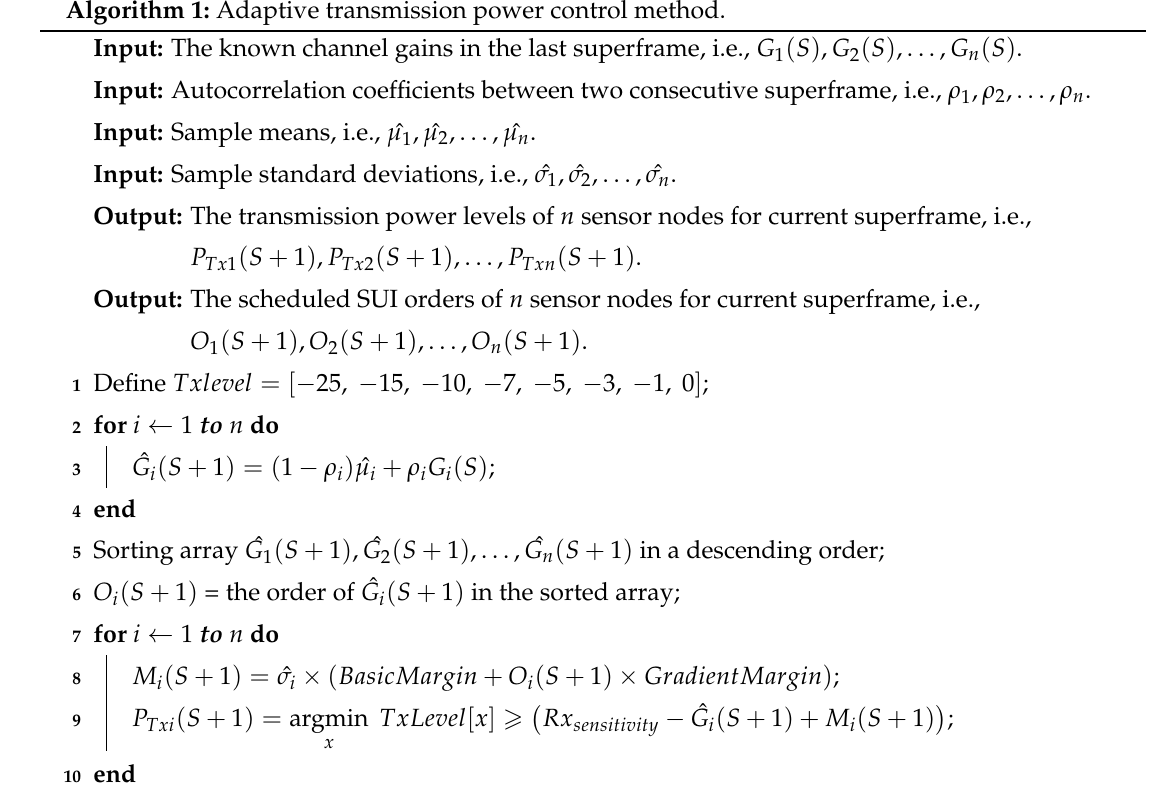
Algorithm 1: Adaptive transmission power control method.